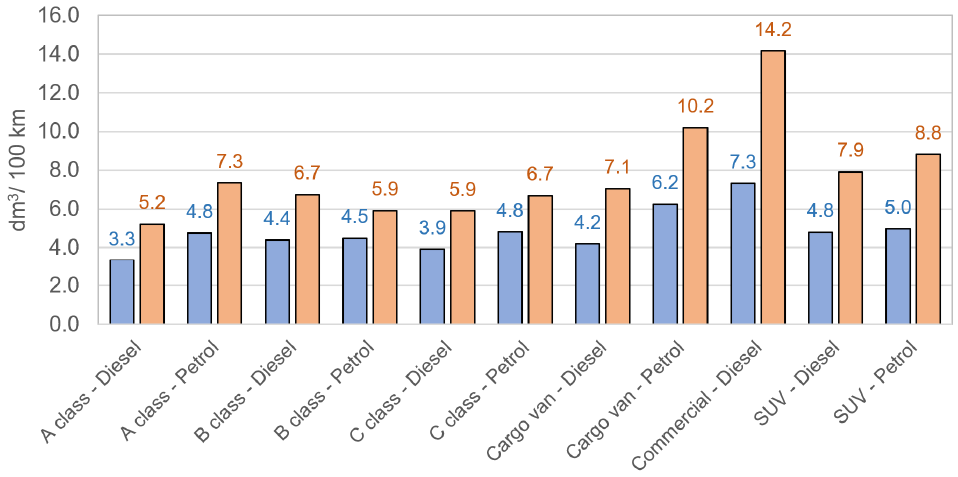
Figure 4. Comparison of fuel consumption (dm 3 per 100 km) of ICE cars—producers’ data and fleet-specific measure- ments. Figure 5. Comparison of carbon emissions (g CO 2 /km) of ICE and BEV cars—producers’ data, fleet-specific measurements and real usage data.